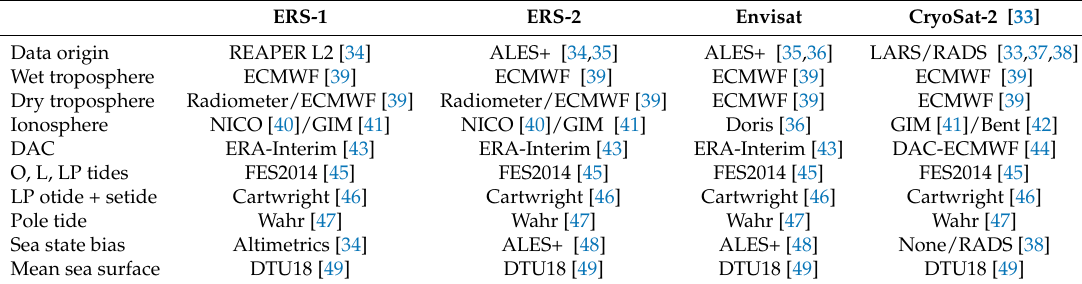
Table 1. Data origin and applied geophysical corrections. O, L, LP tides are the Ocean tide, ocean loading tide, long-periodic non-equilibrium ocean tide, LP otide + setide includes the long-periodic ocean tide and the solid earth